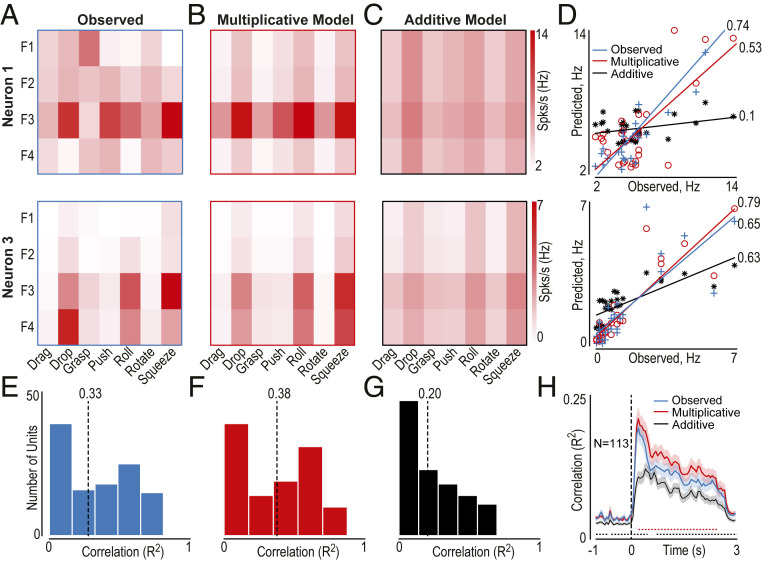
Multiplicative vs. additive mixing of OMA identity with visual format information. (A) Observed response matrix with half of the trials of two neurons (neurons 1 and 3) shown in Fig. 1C. F1 to F4 indicate the four formats (stand lateral, sit lateral, stand frontal, sit frontal), whereas the horizontal axis indicates the OMA exemplars. (B and C) Predicted responses for the multiplicative and additive models built on the other half of the trials of the same two neurons. (D) Observed response plotted against the response predicted with each of the models (multiplicative, additive) and the response observed with the other half of the trials (observed). Correlations between a split of the real data and observed (blue), multiplicative (red), and additive (black) model data. The values at the extremity of each line indicate R2. (E–G) Distribution of R2 between half of the trials and the other half of observed data (E), multiplicative model data (F), and additive model data (G). Dashed lines represent the median R2 value (indicated above). (H) Time-resolved correlation analysis (time bin, 150 ms; step, 50 ms) between a random split half of the real data and 1) the remaining data (blue), 2) multiplicative model data (red), and 3) additive model data (black) for the entire OMA-selective population. Colored dashed lines highlight the significant bins (only series of at least four consecutive bins with P < 0.05 are shown) for the comparison of each model with observed data.